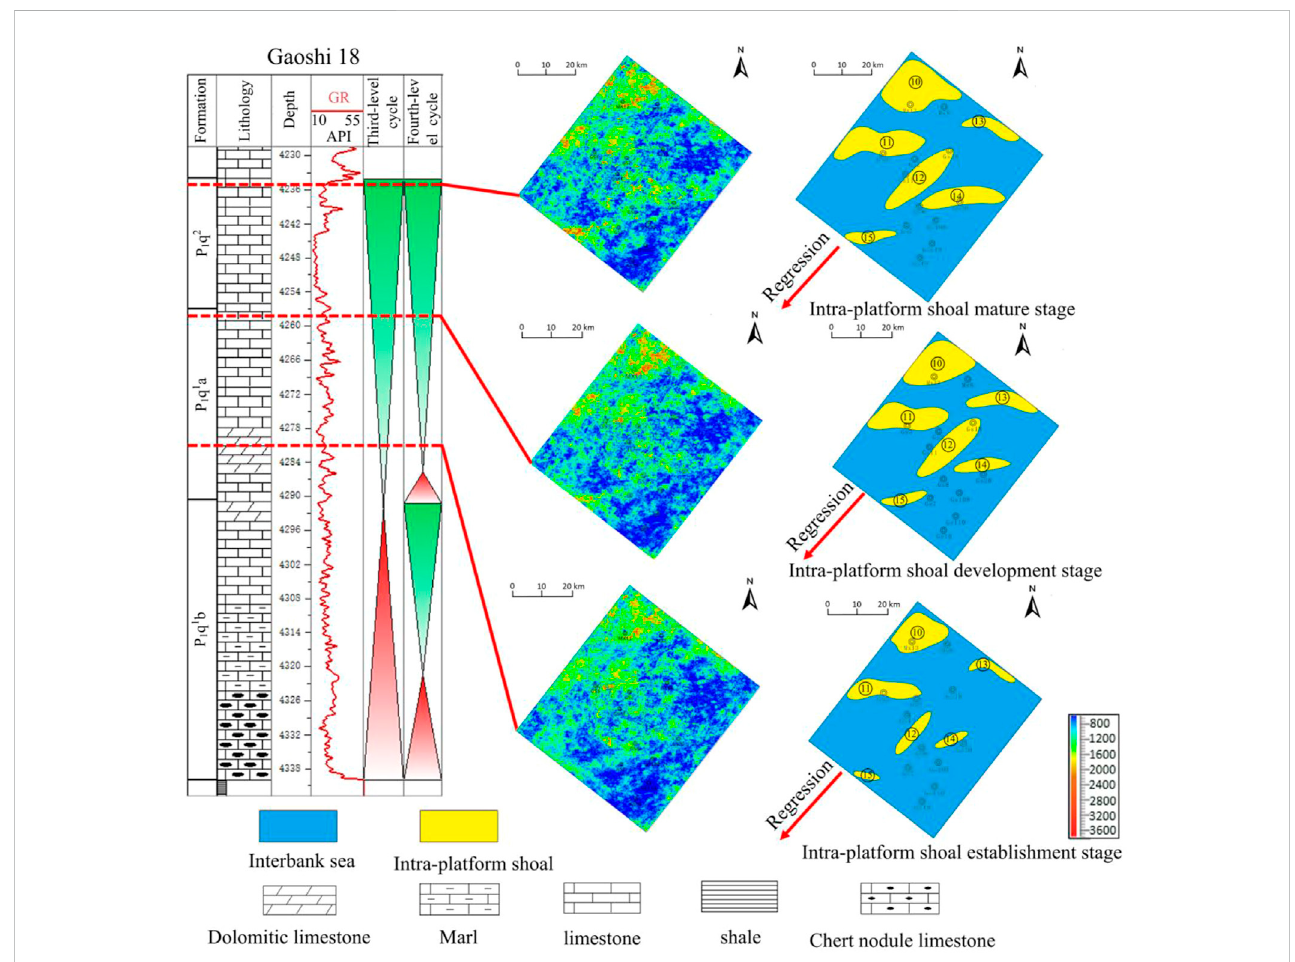
FIGURE 14 Typical root mean square amplitude attribute slice and corresponding sedimentary microfacies interpretation in HST2.